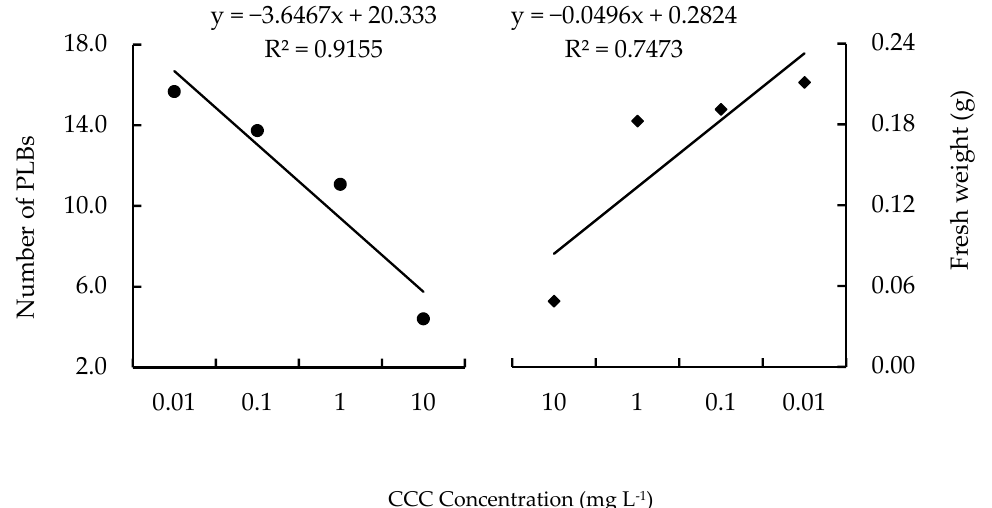
Figure 4. Correlation between the number of PLBs (left) and fresh weight (right) with CCC concentrations of the culture medium. Mean data were used for these